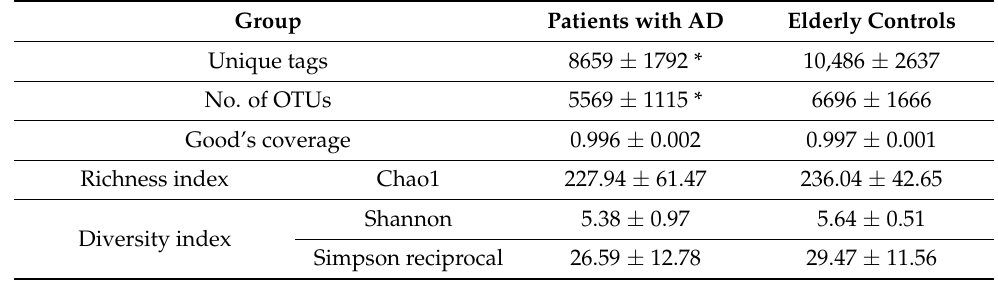
Table 2. Number of unique tags, operational taxonomic units (OTUs), Good’s coverage, and alpha